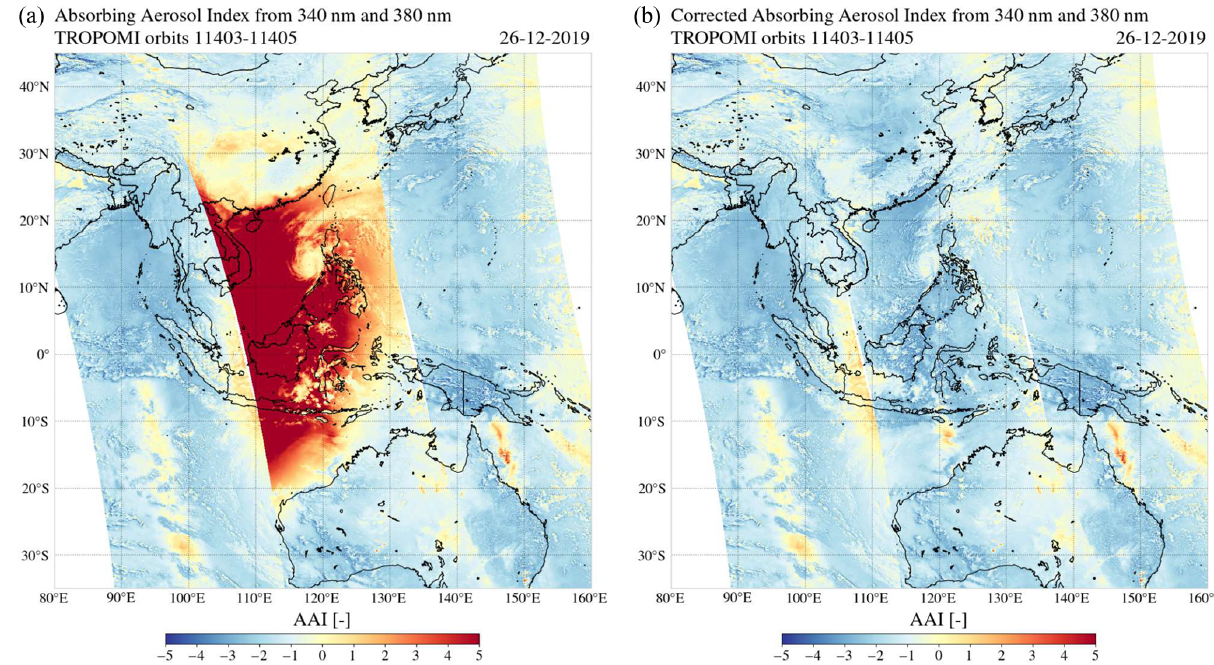
Figure 16. The absorbing aerosol index from the 340 and 380nm wavelength pair by TROPOMI on 26 December 2019 in Southeast Asia in orbits 11403–11405, uncorrected (a) and after the solar irradiance correction (b) .